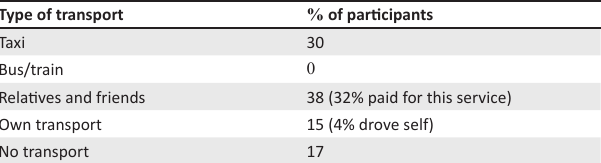
TABLE 3: Transport used by participants ( n = 53). Type of transport